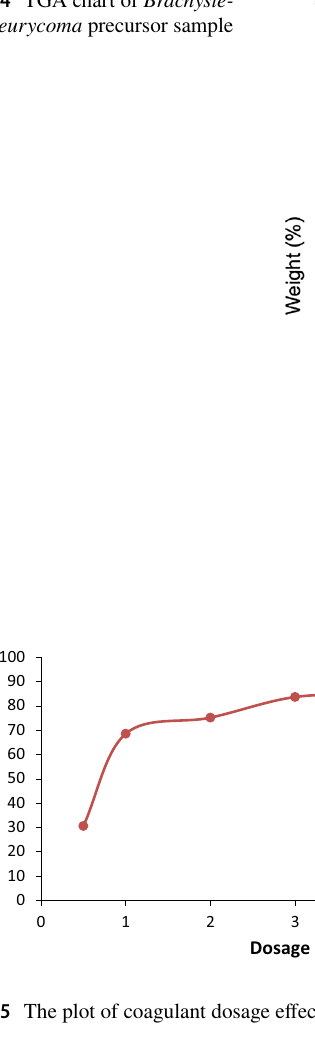
Fig. 4 TGA chart of Brachyste- gia eurycoma precursor sample